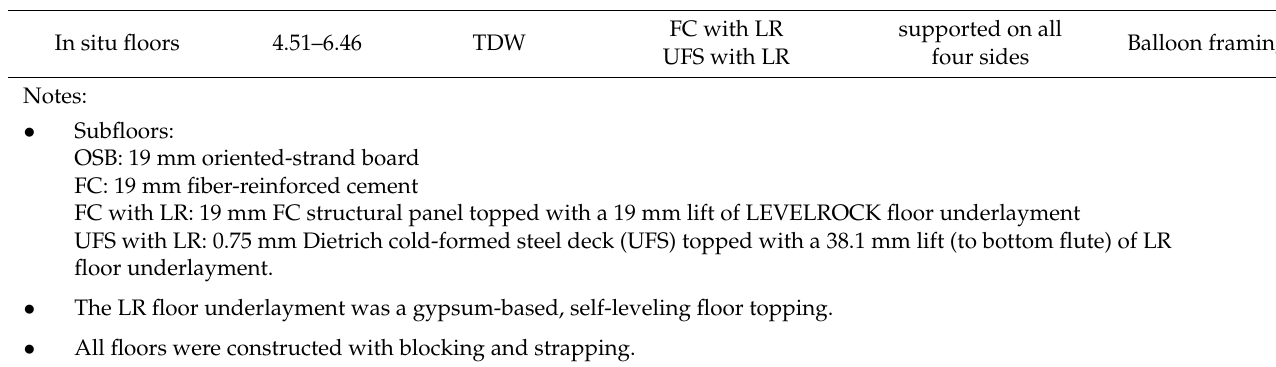
Figure 2. Cold-formed steel joists used in Parnell et al. [35]: ( a ) Dietrich C-stud joists (CSW); ( b ) Dietrich TradeReady joists (TDW). The figures are reproduced from the company website (www.clarkdietrich.com (accessed on 1 January 2022)).